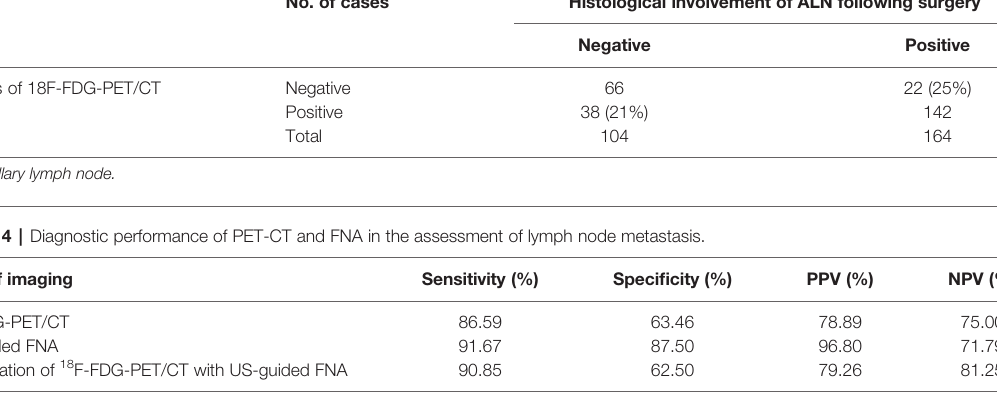
Findings of 18F-FDG-PET/CT